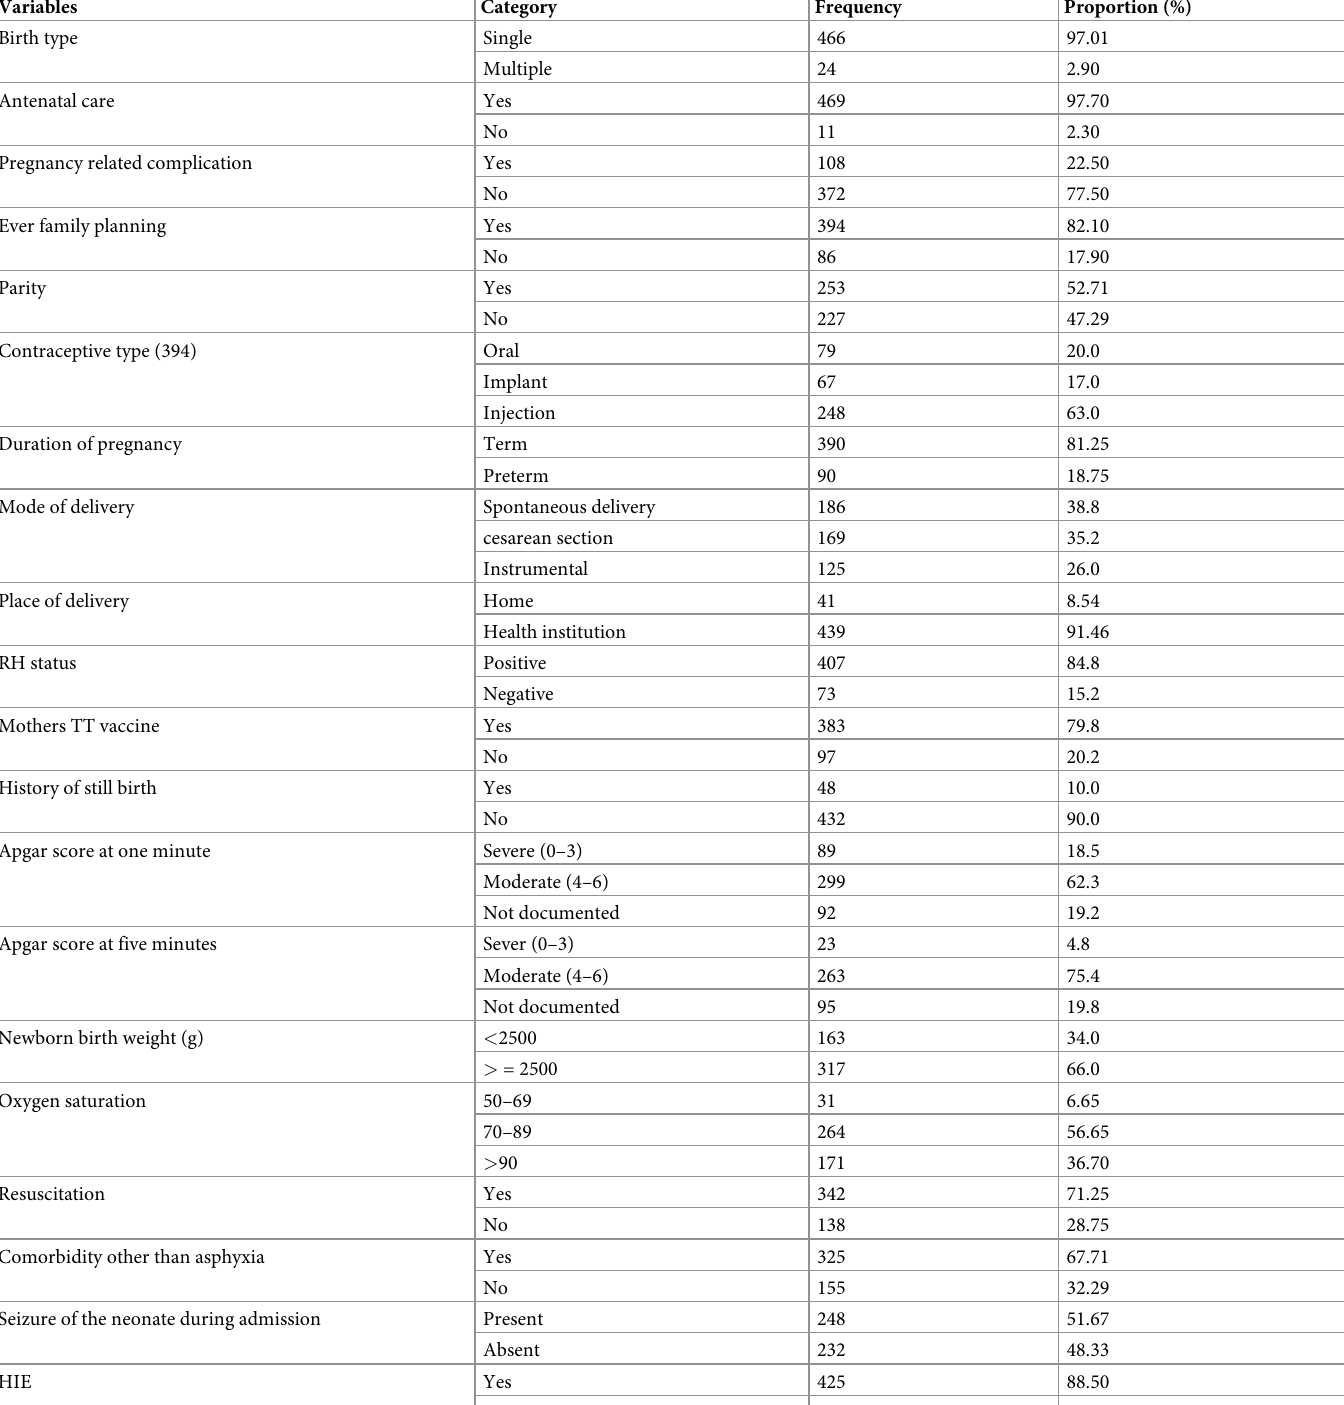
Table 2. New-born and maternal clinical characteristics in Northwest Ethiopia selected hospitals from November 1, 2018, to November 1,